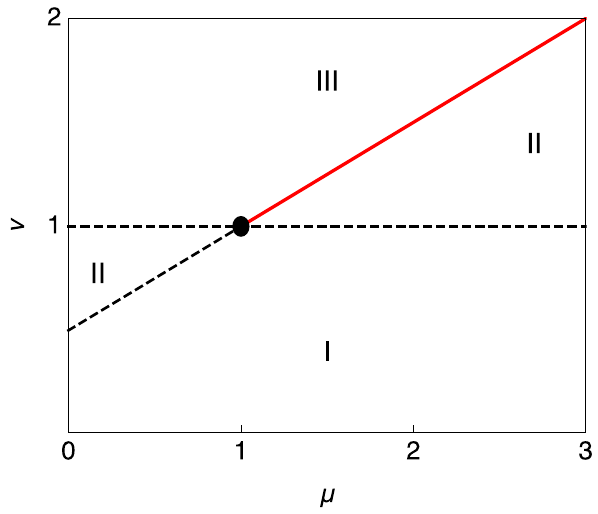
Figure 4. Different noise regimes arising under the scaling (cid:31) 0 = (cid:31) /ǫ µ , a 0 = a ǫ ν in the limit ǫ → 0